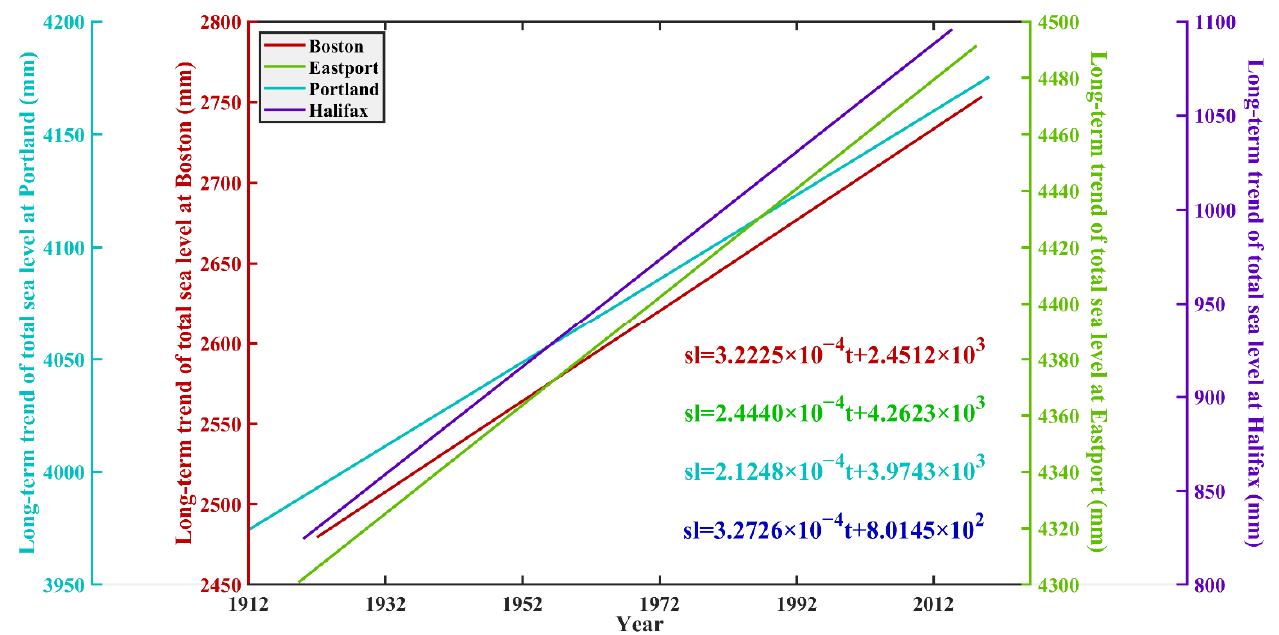
Figure 9. The long-term linear trend of total sea levels at four stations: Boston (red line), Eastport (green line), Portland (cyan line), and Halifax (purple line). Equations in the figure represent the linear trend fitting for four tide gauges. sl is the total sea level (mm), t is the time (h).